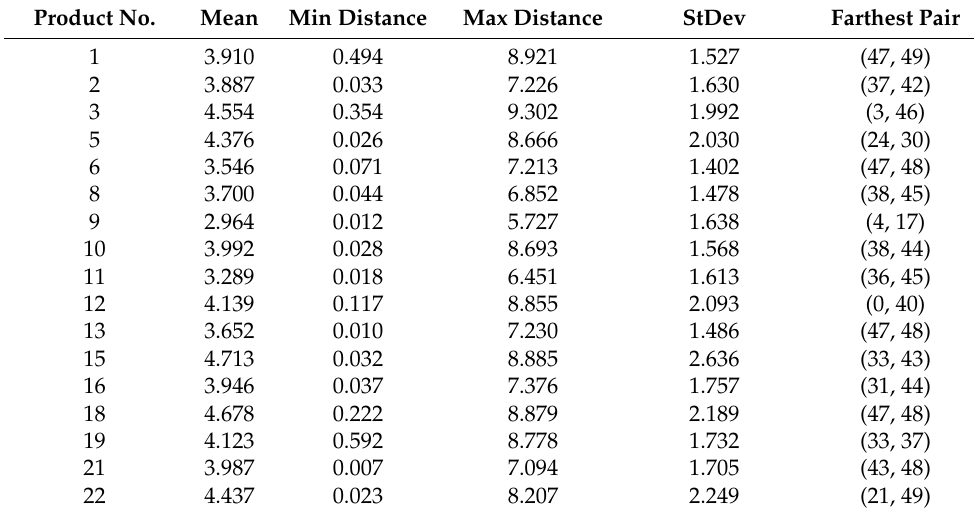
Table 5. Solutions diversity: